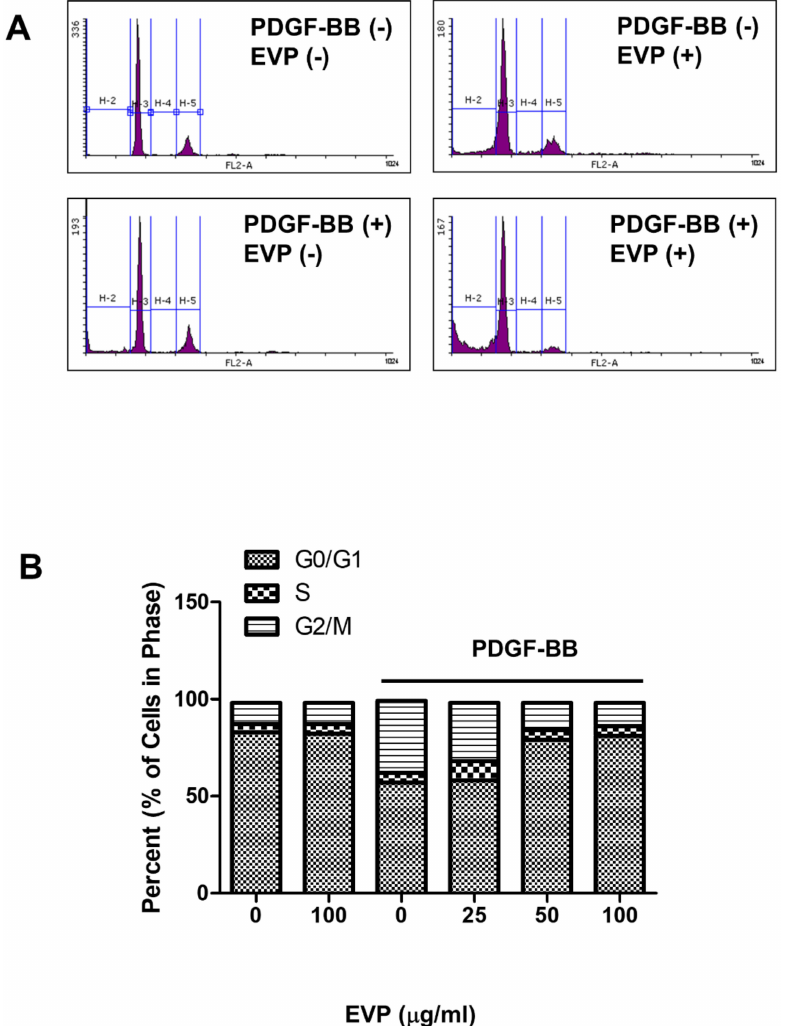
Figure 2. Effect of EVP on the cell cycle in PDGF-BB-induced VSMCs. Cell cycle progression was as- sessed by flow cytometric analysis of DNA. The cells were pre-cultured in serum-free